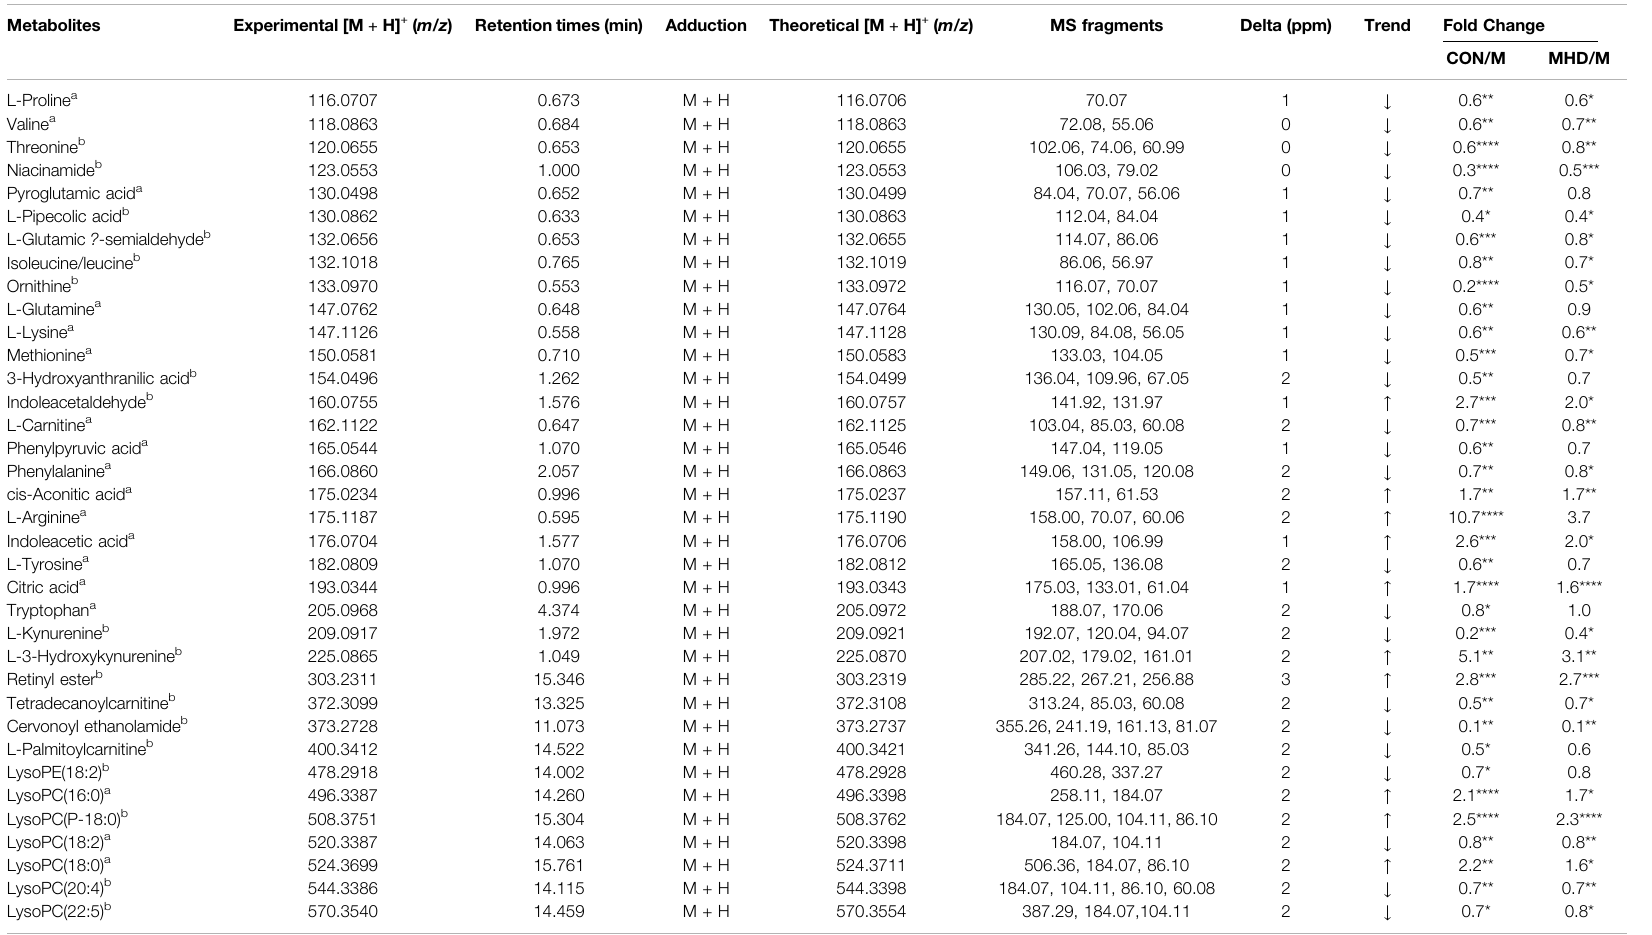
Table 1 | Changes of metabolites in mice with acute liver failure.